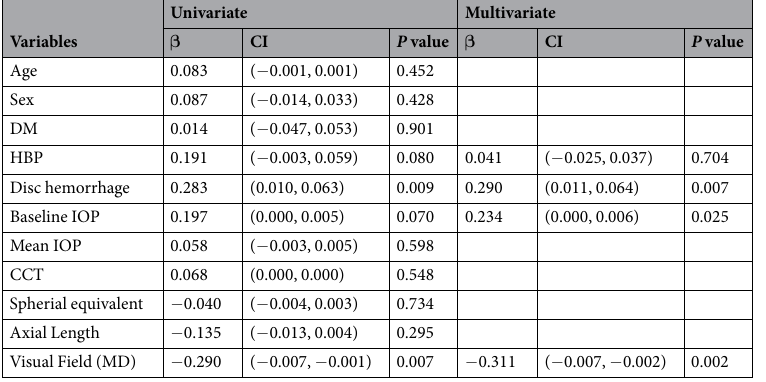
Table 5. Association Between INL thicknesses and demographic, ocular variables, and visual field mean deviation: Univariable and multivariable analysis. INL = inner nuclear layer; DM = diabetes mellitus; HBP = hypertension; IOP = intraocular pressure; CCT = central corneal thickness; MD = mean deviation; β = estimated regression coefficient, CI = confidence